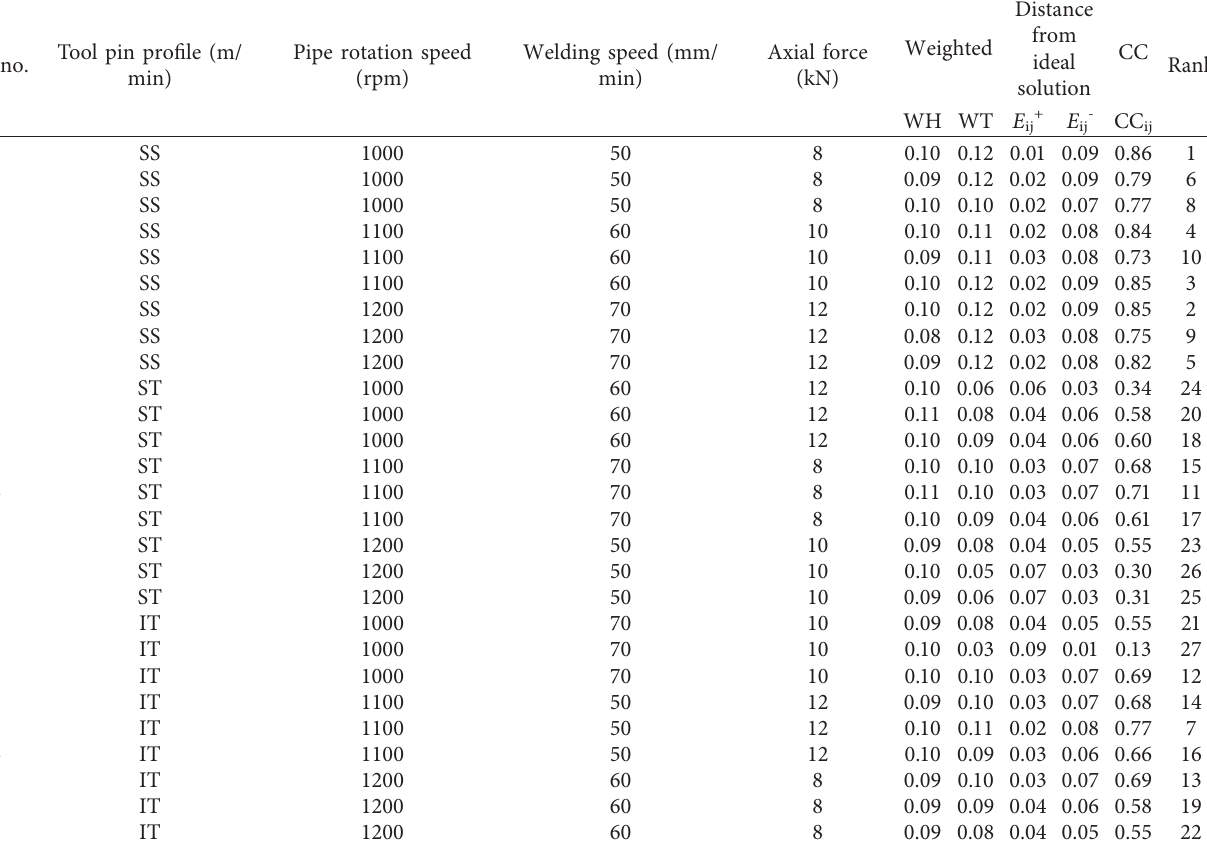
Table 7: TOPSIS evaluation for dry friction stir welding of AISI 4340 steel.